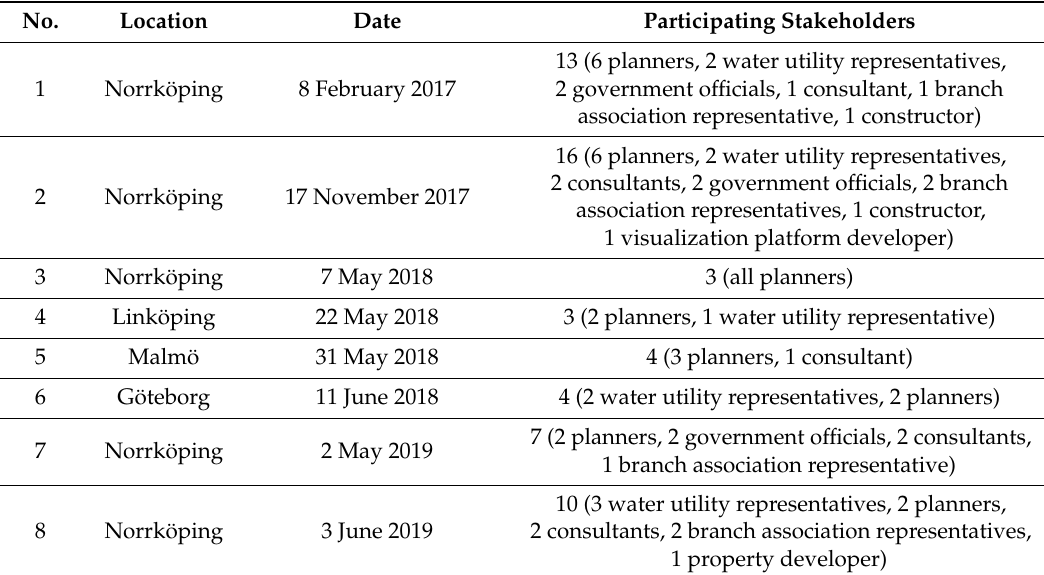
Table 1. Overview of stakeholder workshops and professions of the